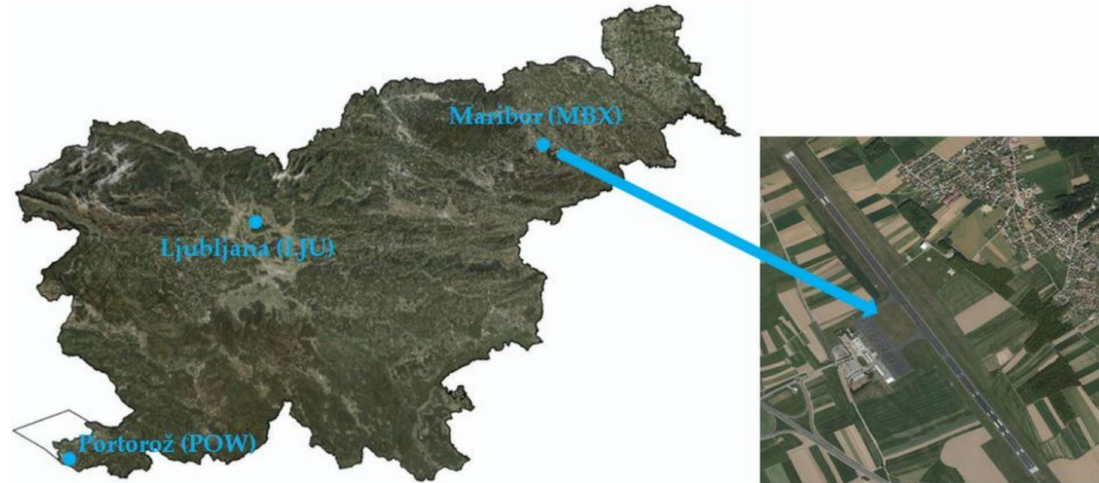
Figure 1. Location of Edvard Rusjan Airport in Maribor. Source: Administration of the Republic of Slovenia for Civil Protection and Disaster Relief and Surveying and Mapping